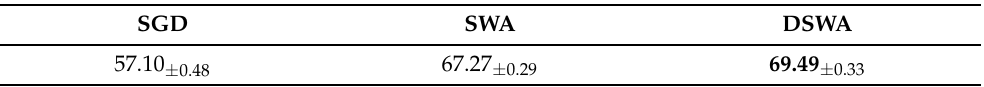
Figure 4. Test accuracy comparison between PSWA and its backbone SGD. The sub-figures in the left/middle/right columns correspond to VGG16/PreResNet-164/WideResNet-28-10, respectively. The sub-figures in the top/bottom rows correspond to dataset CIFAR-10/CIFAR-100, respectively. Table 4. Test accuracy (%) comparison among SGD, SWA, and DSWA on CIFAR-10, based on a toy CNN model. The preceding SGD procedure did not converge. The best results are bolded .